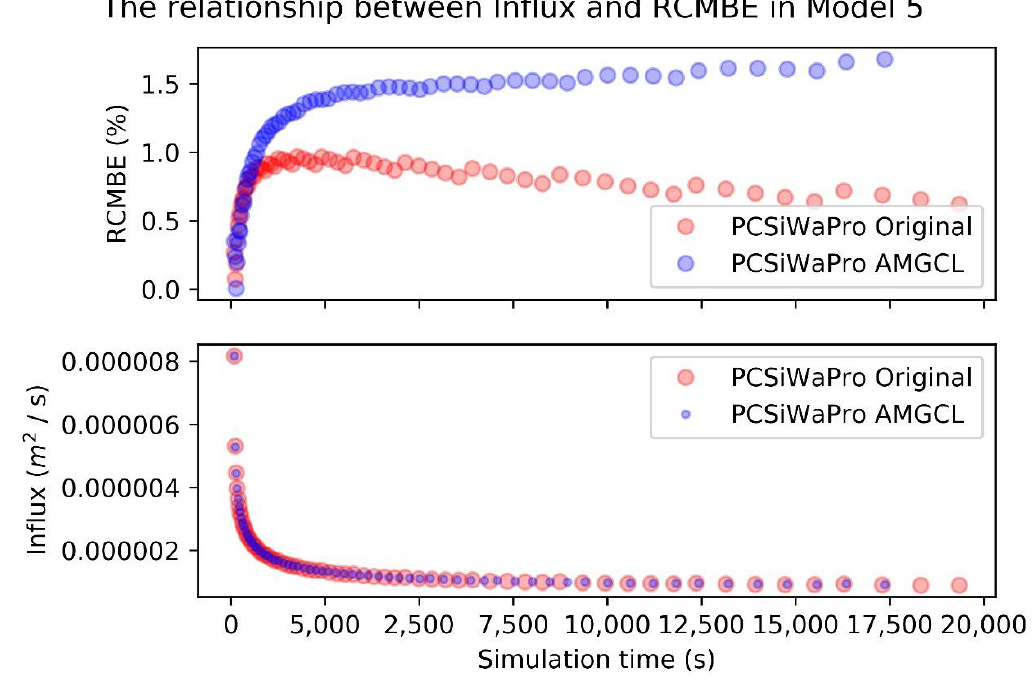
Figure 6. The relationship between the RCMBE computed with PCSiWaPro Original (red) and PCSiWaPro AMGCL (blue) and the computed influx for the first 10% of the simulation period in Model 5. Since the computed influx is identical in both programs, the difference in the mass balance must be explained by differently computed pressure heads.